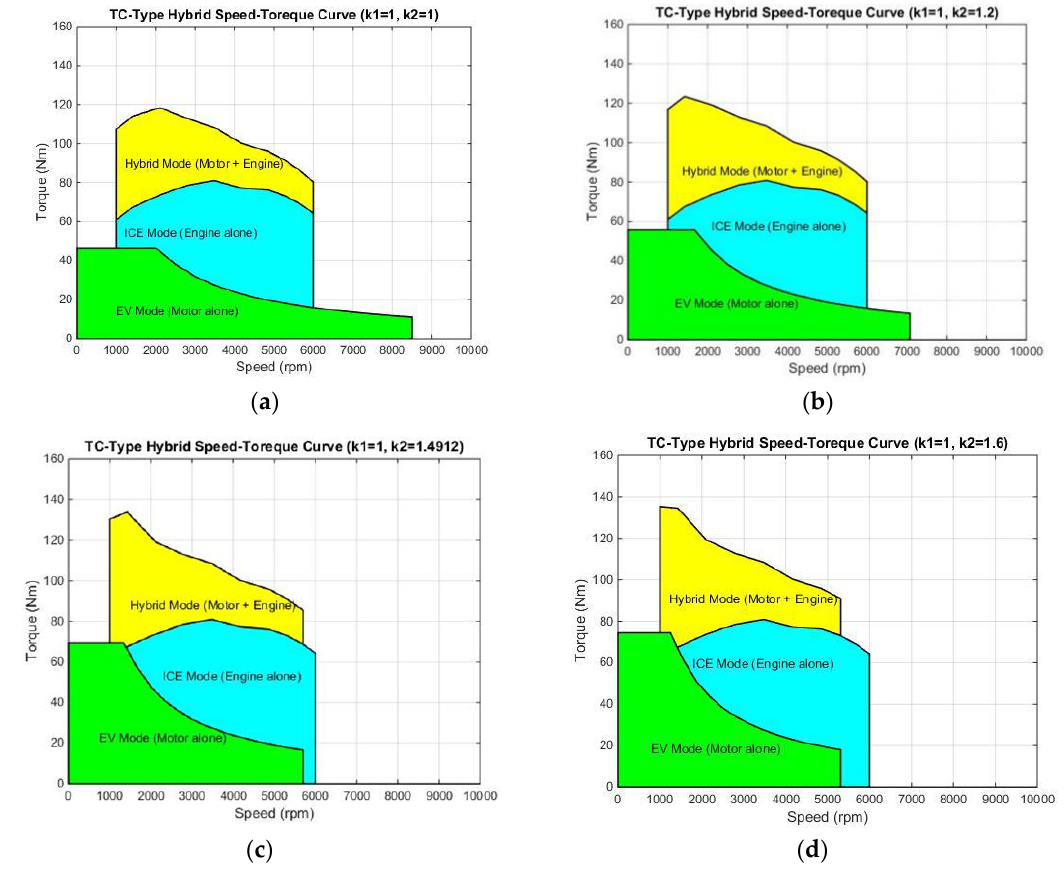
Figure 5. ( a ) Power region ( k 1 = 1, k 2 = 1). ( b ) Power region ( k 1 = 1, k 2 = 1.2). ( c ) Power region ( k 1 = 1, k 2 = 1.4912). ( d ) Power region ( k 1 = 1, k 2 = 1.6).